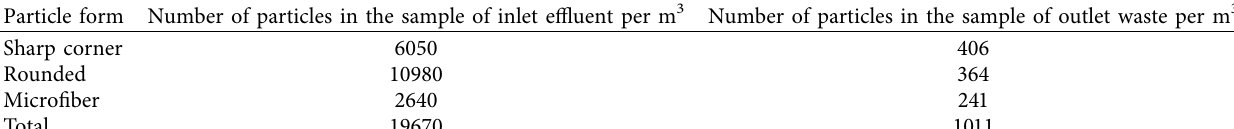
Table 5: Results of counting particles by appearance and type in autumn.